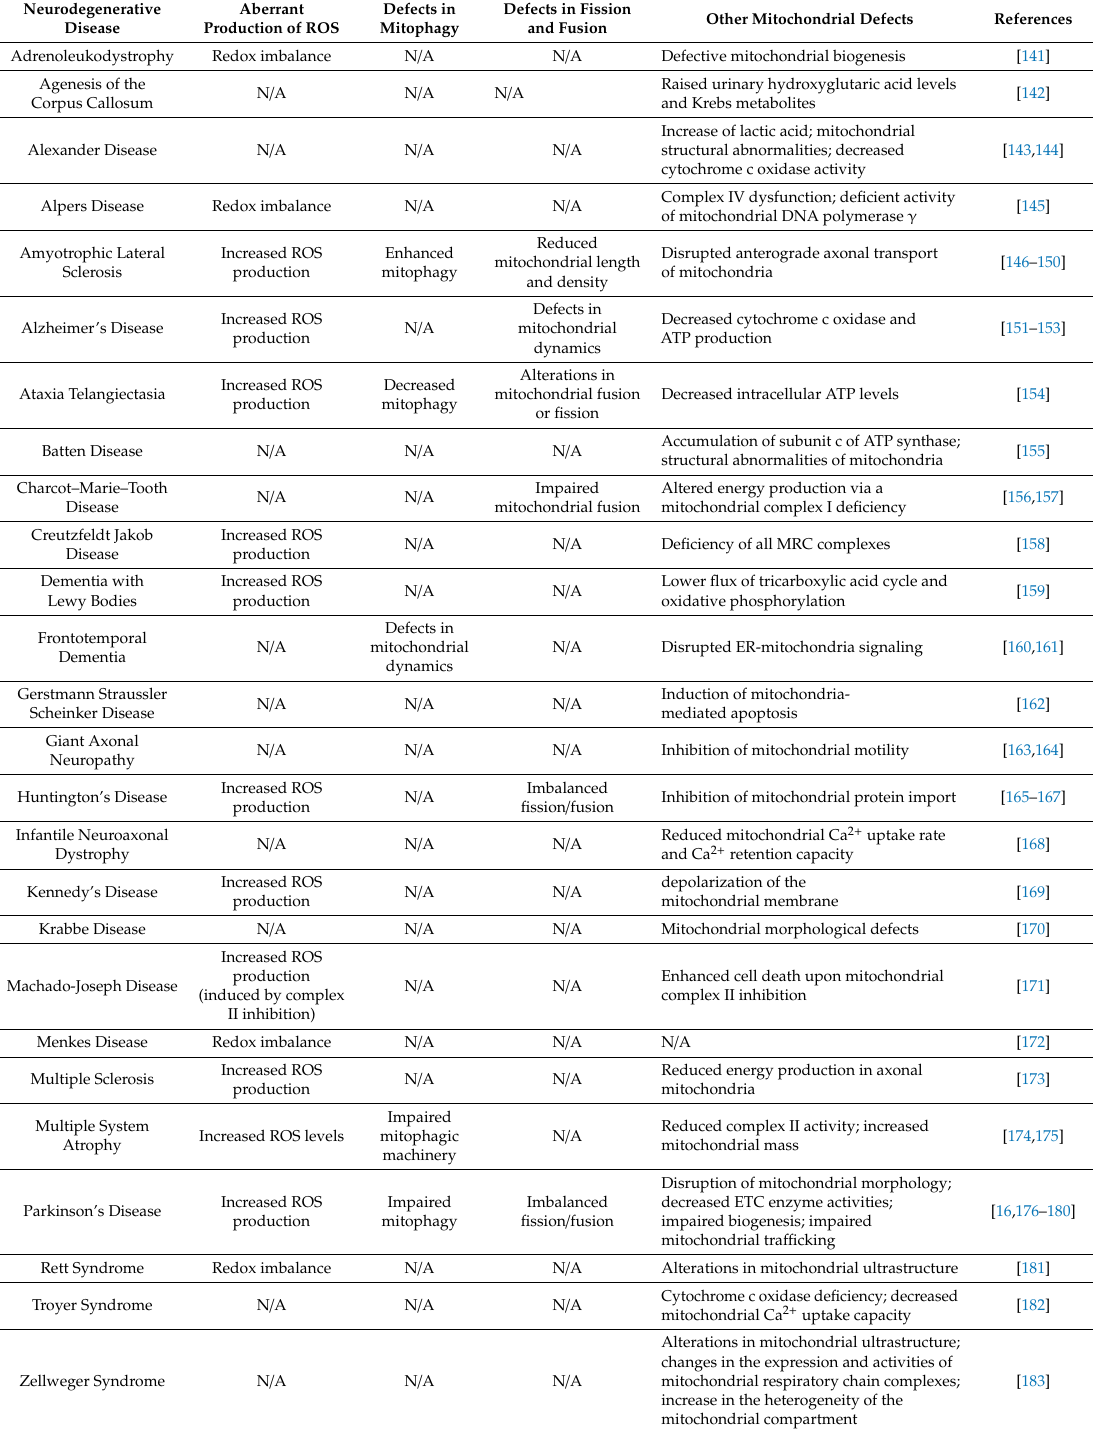
surrounding the delivery of dietary antioxidants to target neurons, insu ffi cient knowledge about cellular ROS homeostasis, and short-termed human cohort studies related to NDD patients. Table 3. A list of representative neurodegenerative diseases that are accompanied by aberrant production of ROS and / or mitochondrial